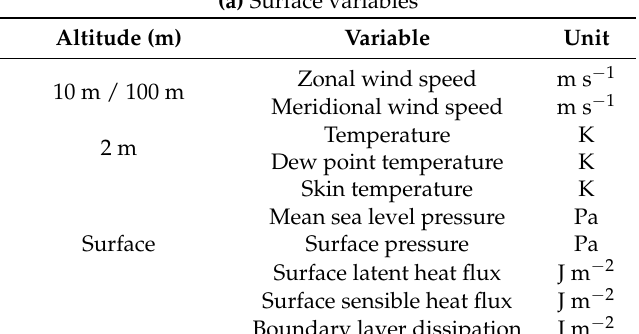
Table 2. Explanatory variables from ECMWF forecasts used as input of the nowcast model LR obs